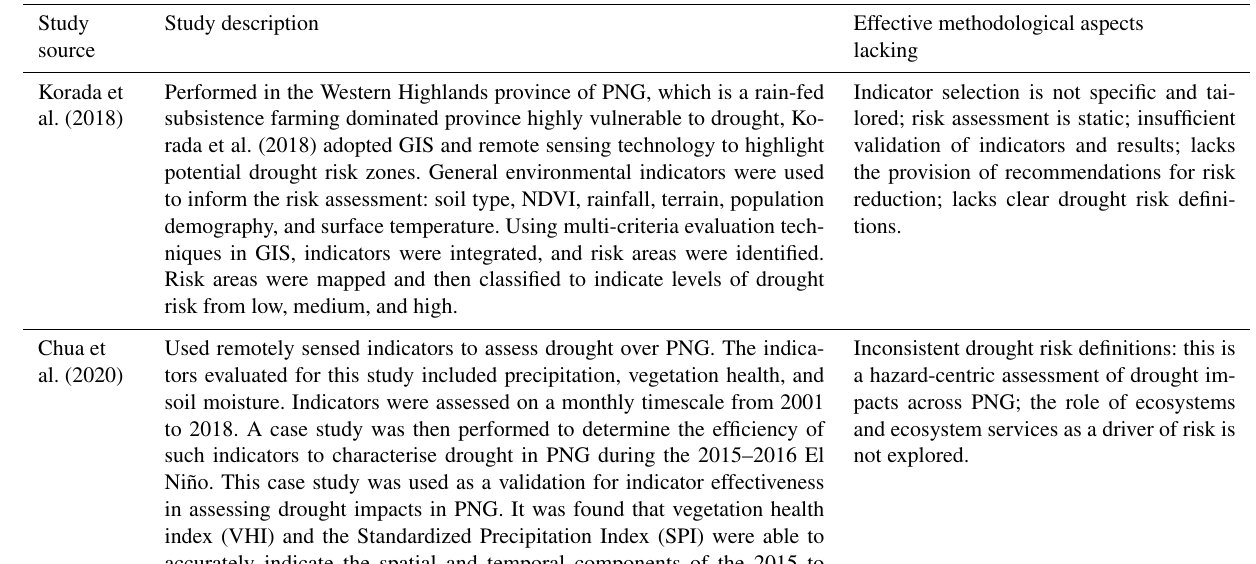
Table 1. An analysis of previous drought assessment studies in PNG outlining the methodological aspects lacking. Study